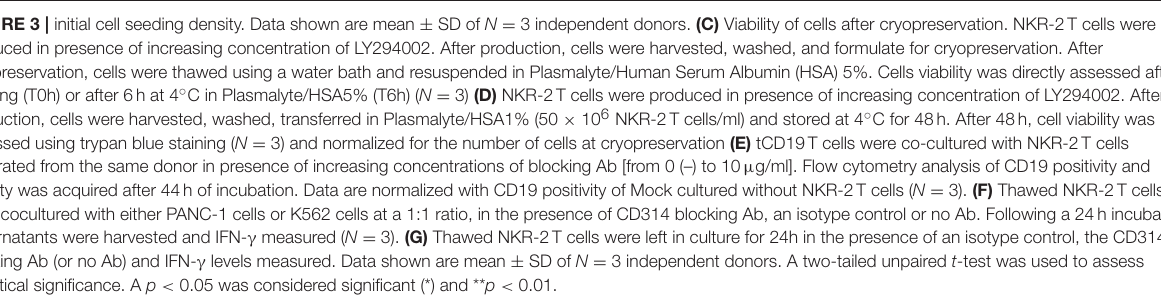
FIGURE 3 | initial cell seeding density. Data shown are mean ± SD of N = 3 independent donors. (C) Viability of cells after cryopreservation. NKR-2T cells were produced in presence of increasing concentration of LY294002. After production, cells were harvested, washed, and formulate for cryopreservation. After cryopreservation, cells were thawed using a water bath and resuspended in Plasmalyte/Human Serum Albumin (HSA) 5%. Cells viability was directly assessed after thawing (T0h) or after 6h at 4 ◦ C in Plasmalyte/HSA5% (T6h) ( N = 3) (D) NKR-2T cells were produced in presence of increasing concentration of LY294002. After production, cells were harvested, washed, transferred in Plasmalyte/HSA1% (50 × 10 6 NKR-2T cells/ml) and stored at 4 ◦ C for 48h. After 48h, cell viability was assessed using trypan blue staining ( N = 3) and normalized for the number of cells at cryopreservation (E) tCD19T cells were co-cultured with NKR-2T cells generated from the same donor in presence of increasing concentrations of blocking Ab [from 0 (–) to 10 µ g/ml]. Flow cytometry analysis of CD19 positivity and viability was acquired after 44h of incubation. Data are normalized with CD19 positivity of Mock cultured without NKR-2T cells ( N = 3). (F) Thawed NKR-2T cells were cocultured with either PANC-1 cells or K562 cells at a 1:1 ratio, in the presence of CD314 blocking Ab, an isotype control or no Ab. Following a 24h incubation, supernatants were harvested and IFN- γ measured ( N = 3). (G) Thawed NKR-2T cells were left in culture for 24h in the presence of an isotype control, the CD314 blocking Ab (or no Ab) and IFN- γ levels measured. Data shown are mean ± SD of N = 3 independent donors. A two-tailed unpaired t -test was used to assess statistical significance. A p < 0.05 was considered significant (*) and ** p <